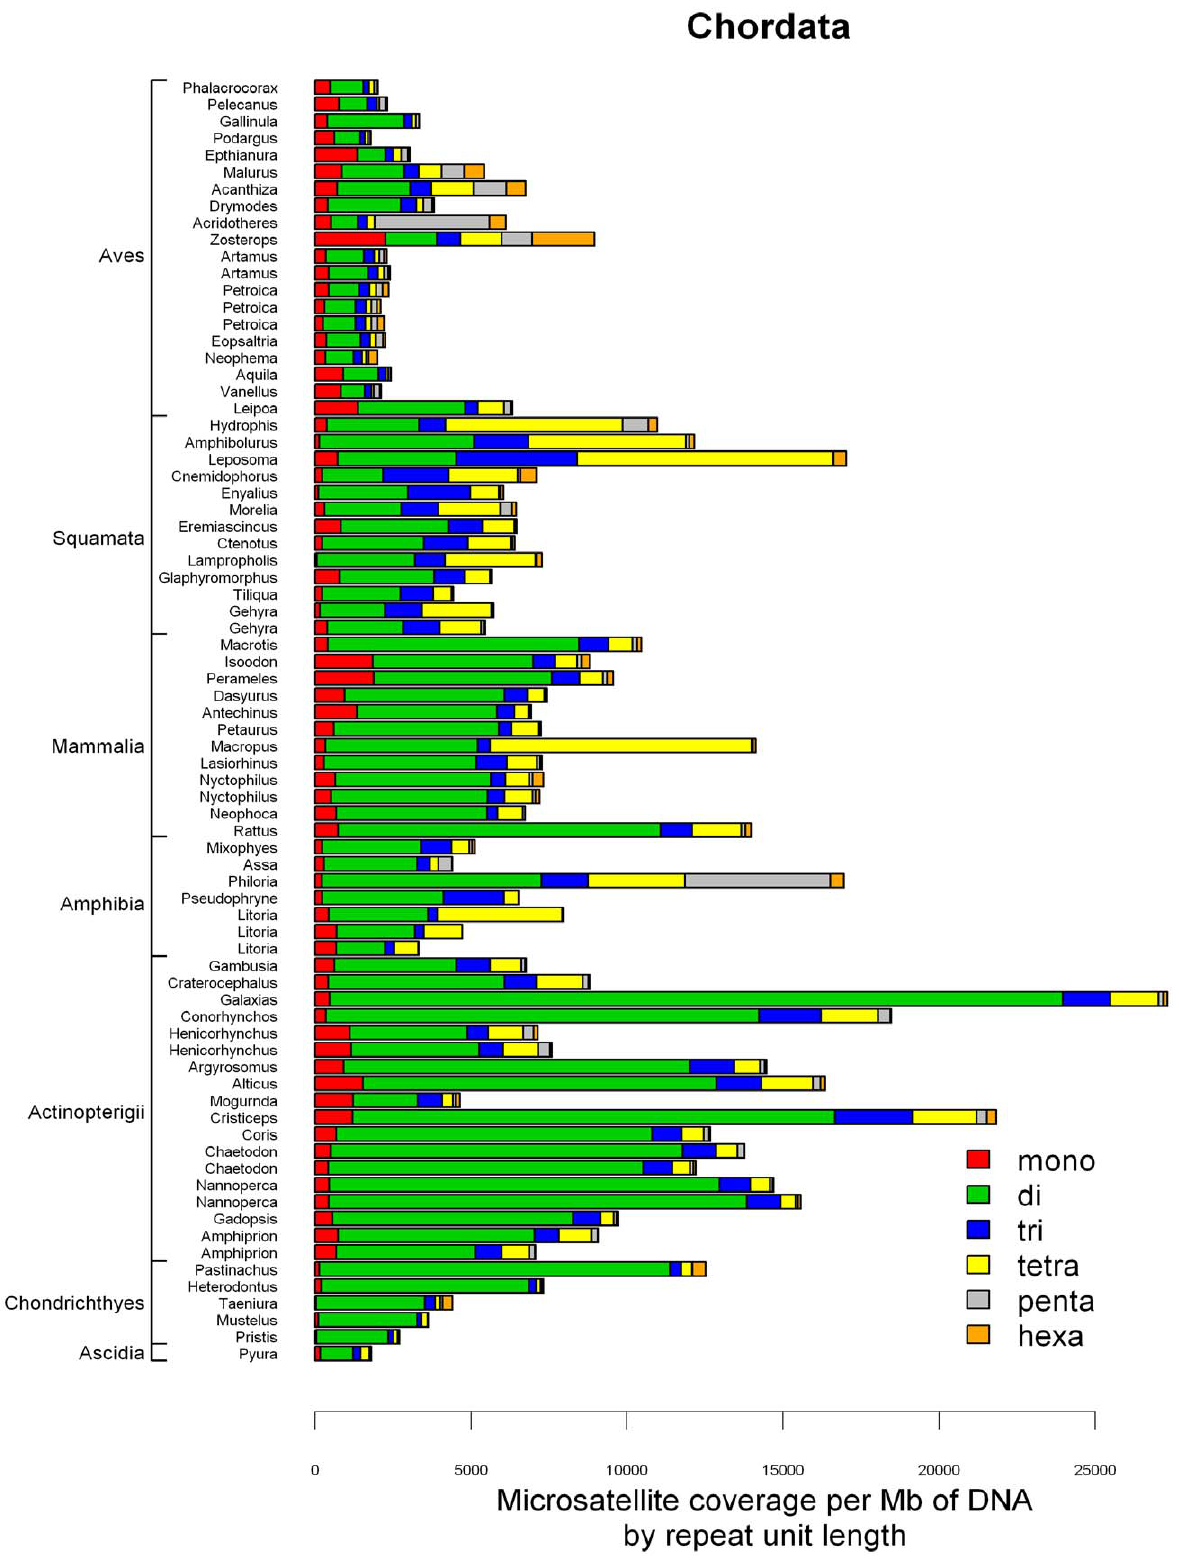
Figure 6. Microsatellite and homopolymer coverage by repeat unit length for Chordata. Microsatellite coverage is the number of bases of microsatellites per Mb of DNA. Coverages of different motifs of the same repeat unit length (mono-hexa) are pooled. Species follow the same order as in Dataset S1 and in Figure 1.